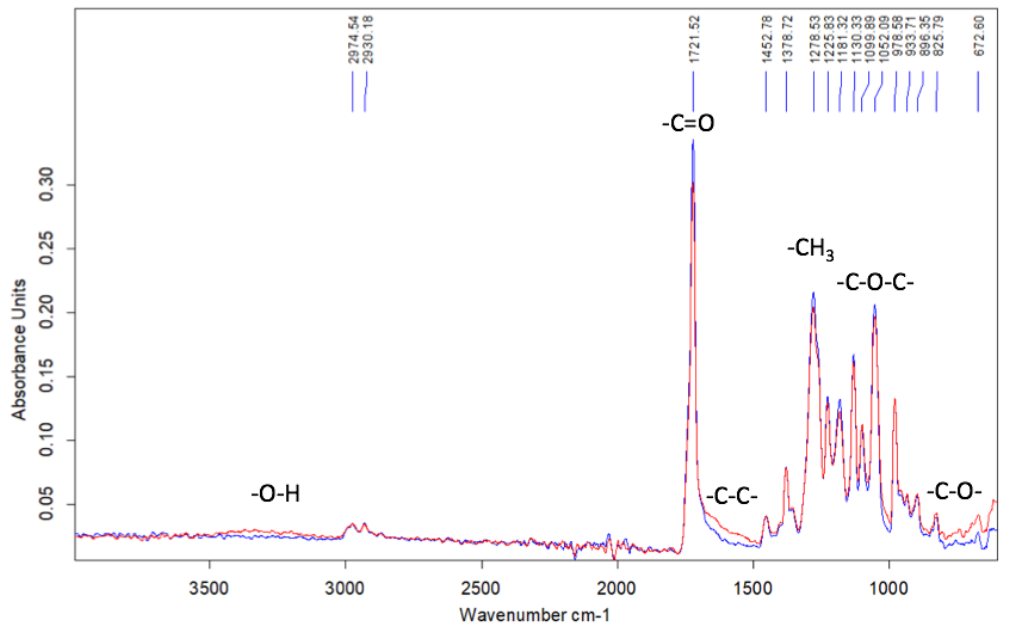
Figure 9. The FTIR spectra of pristine (blue line) and weathered (red line) Hmi /PHB samples. The FTIR spectrum shows a slight decrease in the intensity of the peaks at 1721 cm −1 (C=O group), 1278 cm −1 (CH 3 group), and 1052 cm −1 , (C-O-C group). In the region of 900 – 700 and 1700 – 1500 cm −1 , noticeable changes are observed. This fact suggests the breakage of C-C bonds and the accumulation of OH groups. Even though the weathered Hmi /PHB samples experience minor biodegradation, their supramolecular structure after weathering is changed. The results of the DSC analy- sis are presented in Figure 10. The shape of the melting peak is markedly changed, thus indicating the occurrence of certain processes during the exposure period. Figure 10. DSC scans of hemin/PHB (5 wt.%) nanocomposites before (yellow line) and after weath- ering (blue line): ( A ) first heating run and ( B ) second heating run.